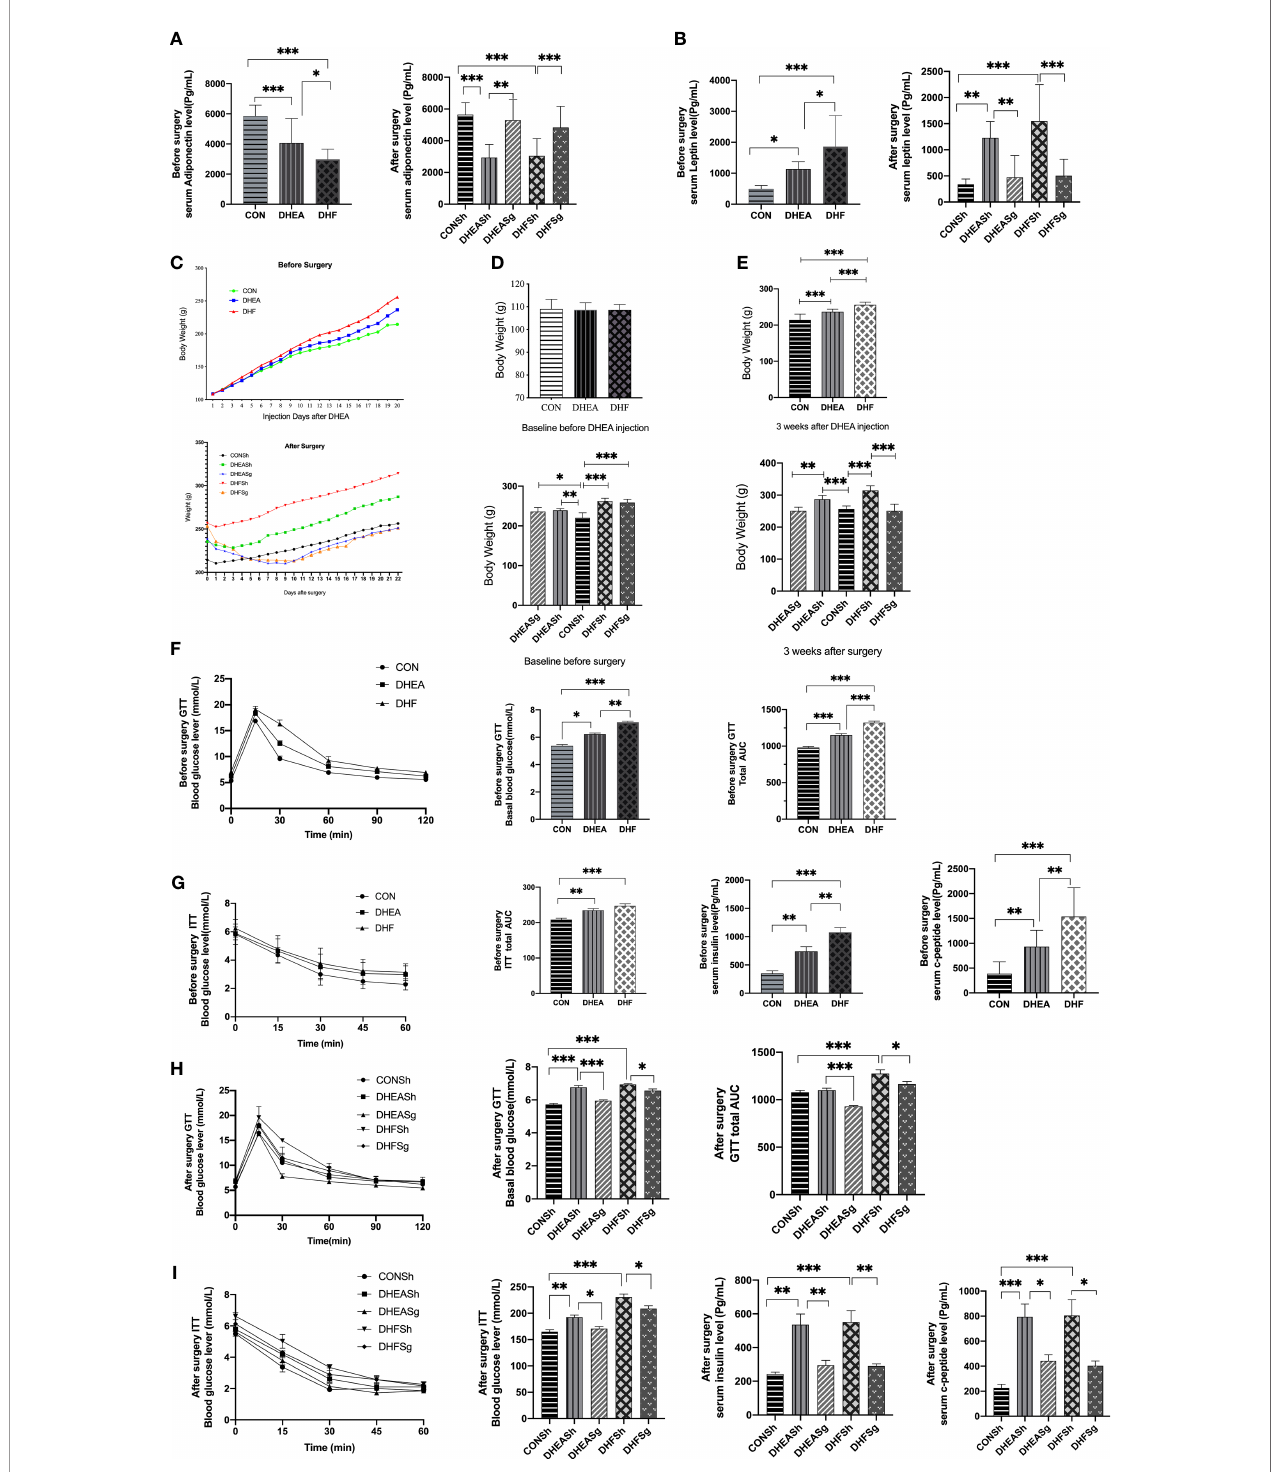
FIGURE 6 | Effects of sleeve gastrectomy on the metabolic hallmarks of polycystic ovary syndrome. Changes in adiponectin (A) and leptin (B) before and after surgery. (C) Changes in body weight before and after surgery. (D) Changes in body weight before DHEA injection and before surgery. (E) Changes in body weight 3 weeks after DHEA injection and 3 weeks after surgery. (F) Results of intraperitoneal glucose tolerance test and (G) intraperitoneal insulin tolerance test before surgery. (H) Results of intraperitoneal glucose tolerance test and (I) intraperitoneal insulin tolerance test after surgery. Serum c-peptide levels before (G) and after (I) surgery. *p < 0.05. **p < 0.01. ***p <